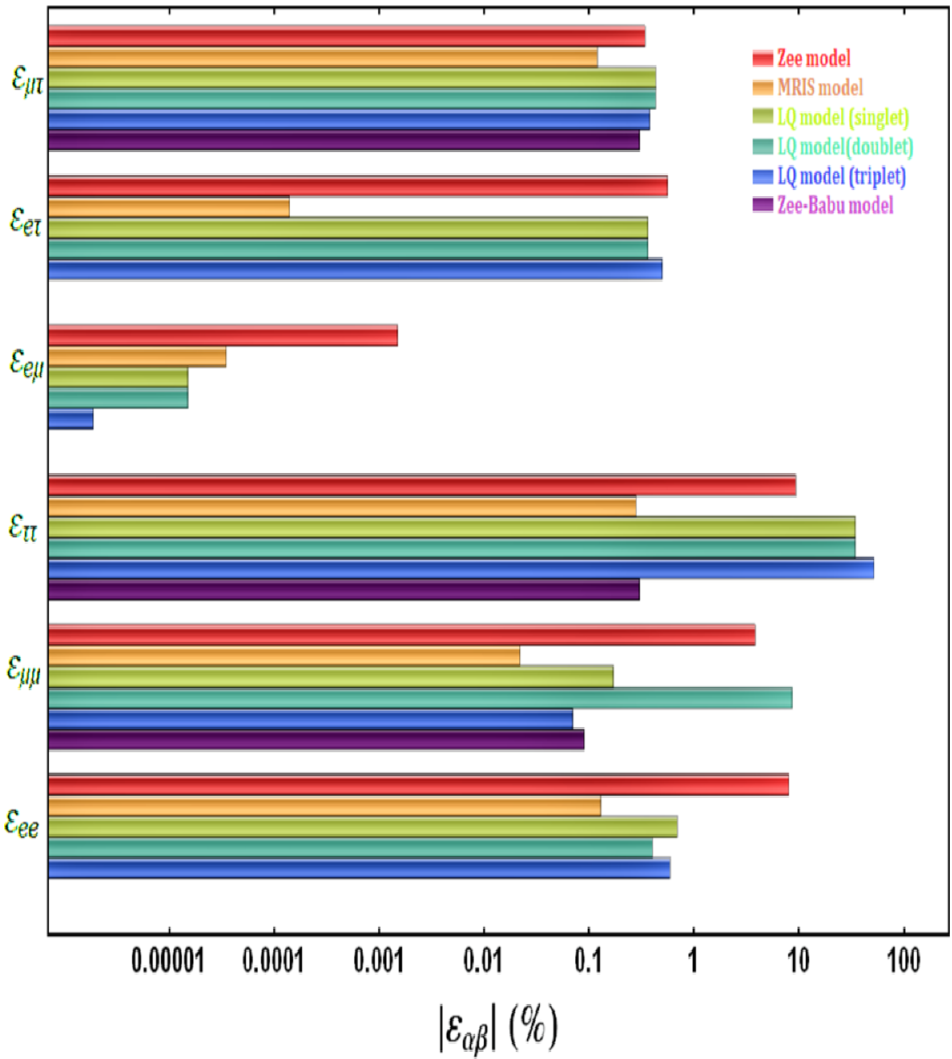
" (cid:11)(cid:12) allowed in di(cid:11)erent classes of radiative j j